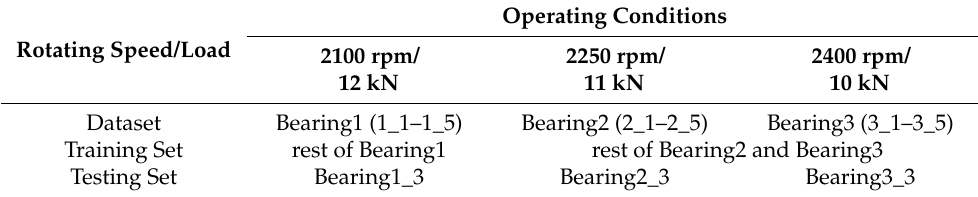
Table 2. Detailed information of XJTU-SY